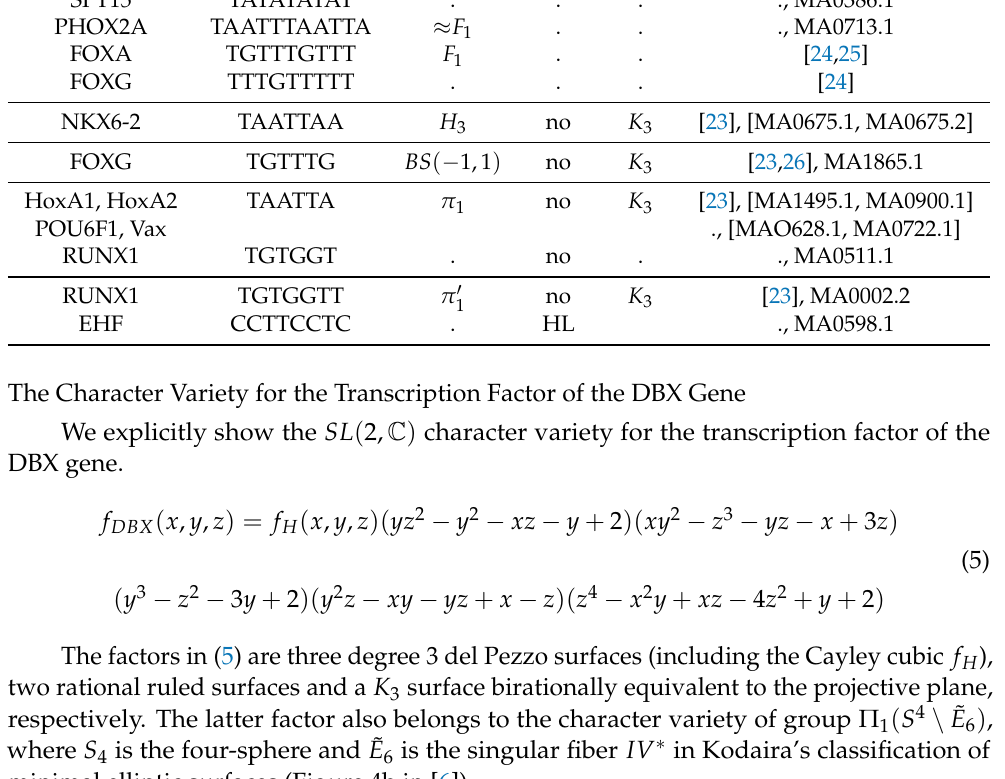
Table 2. Group structure of motifs for a few two-letter transcription factors. The card seq for the mod- ular group H 3 is [ 1,1,2,3,2,8,7,10,18,28, · · · ] . The Baumslag–Solitar group BS ( − 1,1 ) is the funda- mental group of the Klein bottle. The card seq for BS ( − 1,1 ) is [ 1,3,2,5,2,7,2,8,3,8,2,13,2,9,4, · · · ] . The card seq for π 1 is [ 1,4,1,2,4,2,1,7,2,2,4,2,2,8,1,2,7,2,3, · · · ] ; for π (cid:48) , it is 1 [ 1,1,1,2,1,3,3,1,2,2,1,1,9,2,14,2,1, · · · ] . The symbol HL means that the Cayley cubic is part of the Groebner base for the ideal ring of the corresponding SL ( 2, C ) character variety. For three-letter transcription factors, the ideal ring of the corresponding SL ( 2, C ) character variety contains the Fricke–Klein seventh variable polynomial 4, which is a feature of the four-punctured sphere topology. The group structure of three-letter transcription factors not leading to free groups is shown in (Table 5 in [4]). Gene Motif Card Seq Link Type Literature DBX TTTATTA F 1 HL K 3 [23], MA0174.1 SPT15 TATATATAT . . . ., MA0386.1 PHOX2A TAATTTAATTA ≈ F 1 . . ., MA0713.1 TGTTTGTTT F 1 . . [24,25] TTTGTTTTT . . . [24]